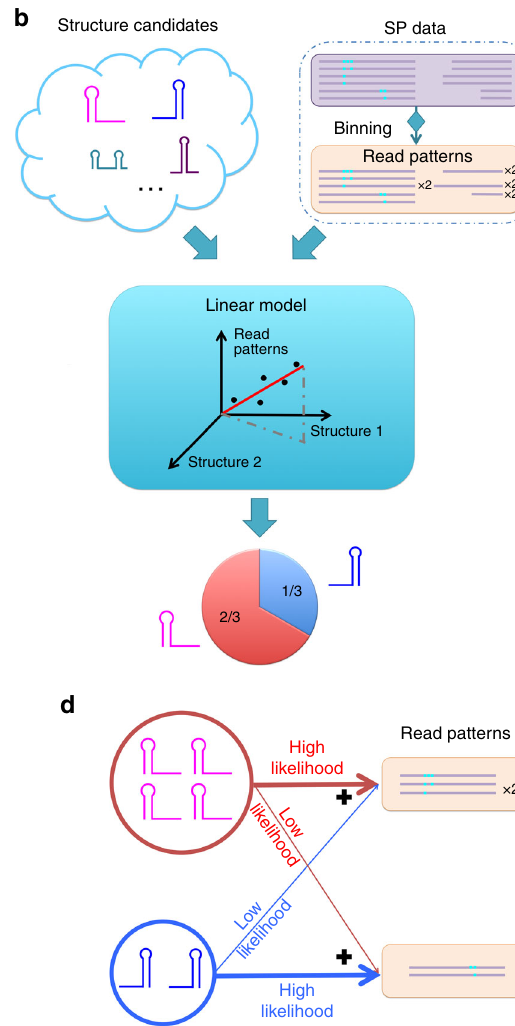
possible read pattern, where modeling at the read resolution is key to SLEQ ’ s ability to unify treatment of truncation and